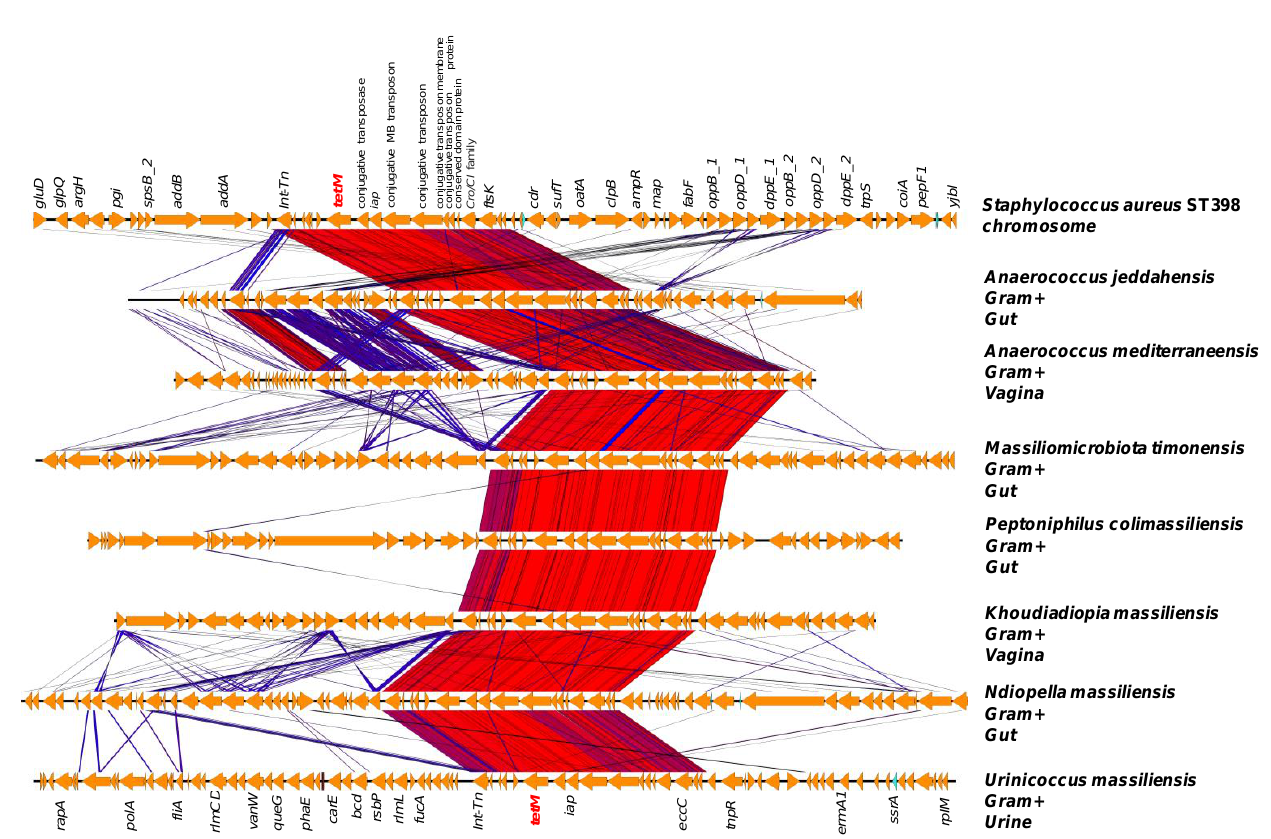
Figure 6. Comparison of the cluster gene surrounded by an integrase and transposase containing tetM ARG found in Staphylococcus aureus ST398 (Accession number: AM990992.1) isolate in a case of human endocarditis and seven new bacterial species described in this work. The figure illustrates potential gene transfer between bacteria isolated from human microbiota. The color gradient from blue to red indicates the percentage of sequence similarity which was calculated via tblastx with the Easyfig tool [33] between the genes in the genetic environments studied.